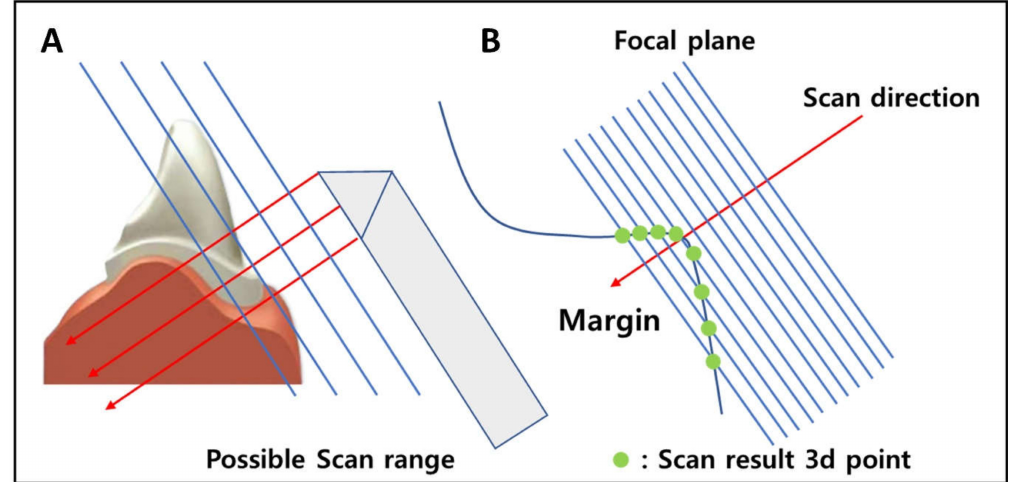
Figure 3. ( A ) Optimal scan data is acquired when scanner is positioned at the optimized focal-depth of scanner. Distance between target point and scanner is greater in mesial-distal area compared to that in buccal-lingual area, causing deviation errors in scanning. ( B ) Optimal scan data is acquired when scan direction is perpendicular to the focal plane. Appropriate angular approach is easily accessible for buccal-lingual margin, but not for mesial-distal margin due to anatomical